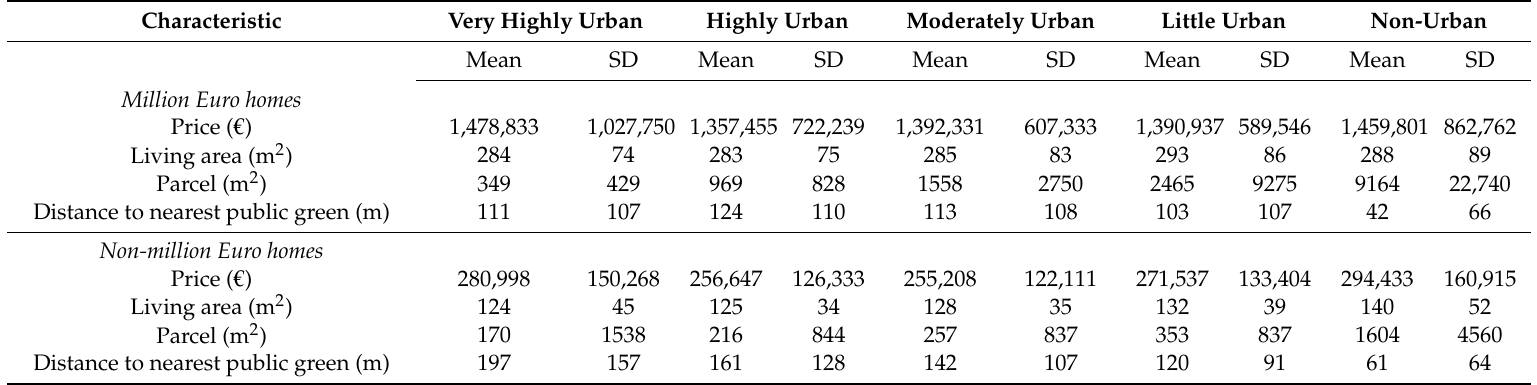
Table 3. Property characteristics by local degree of urbanization.